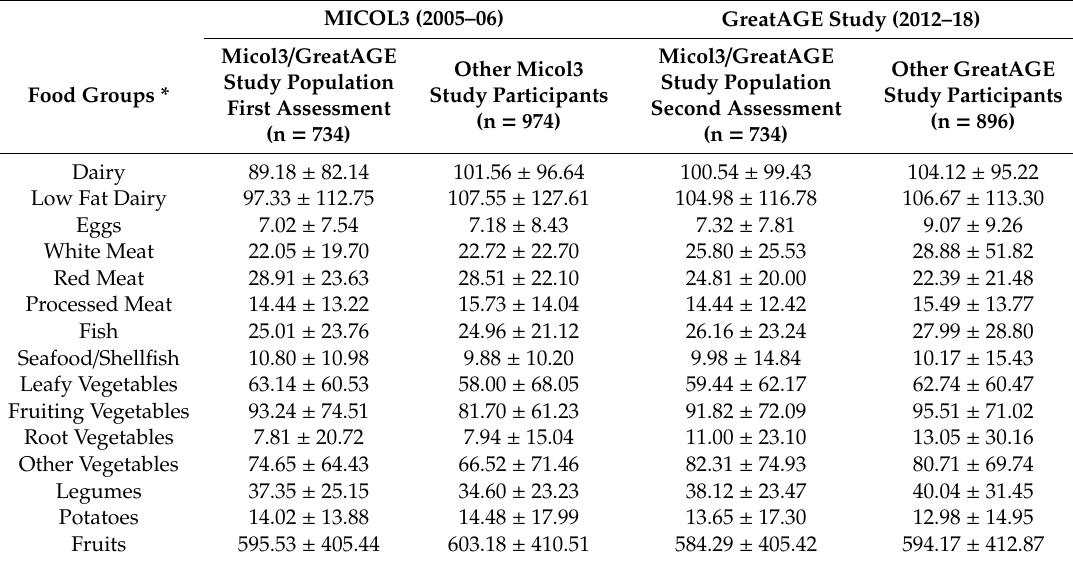
Table 3. Food group intake within the study populations at the two examination periods (MICOL3 (Multicenter Italian study on Cholelithiasis) and GreatAGE